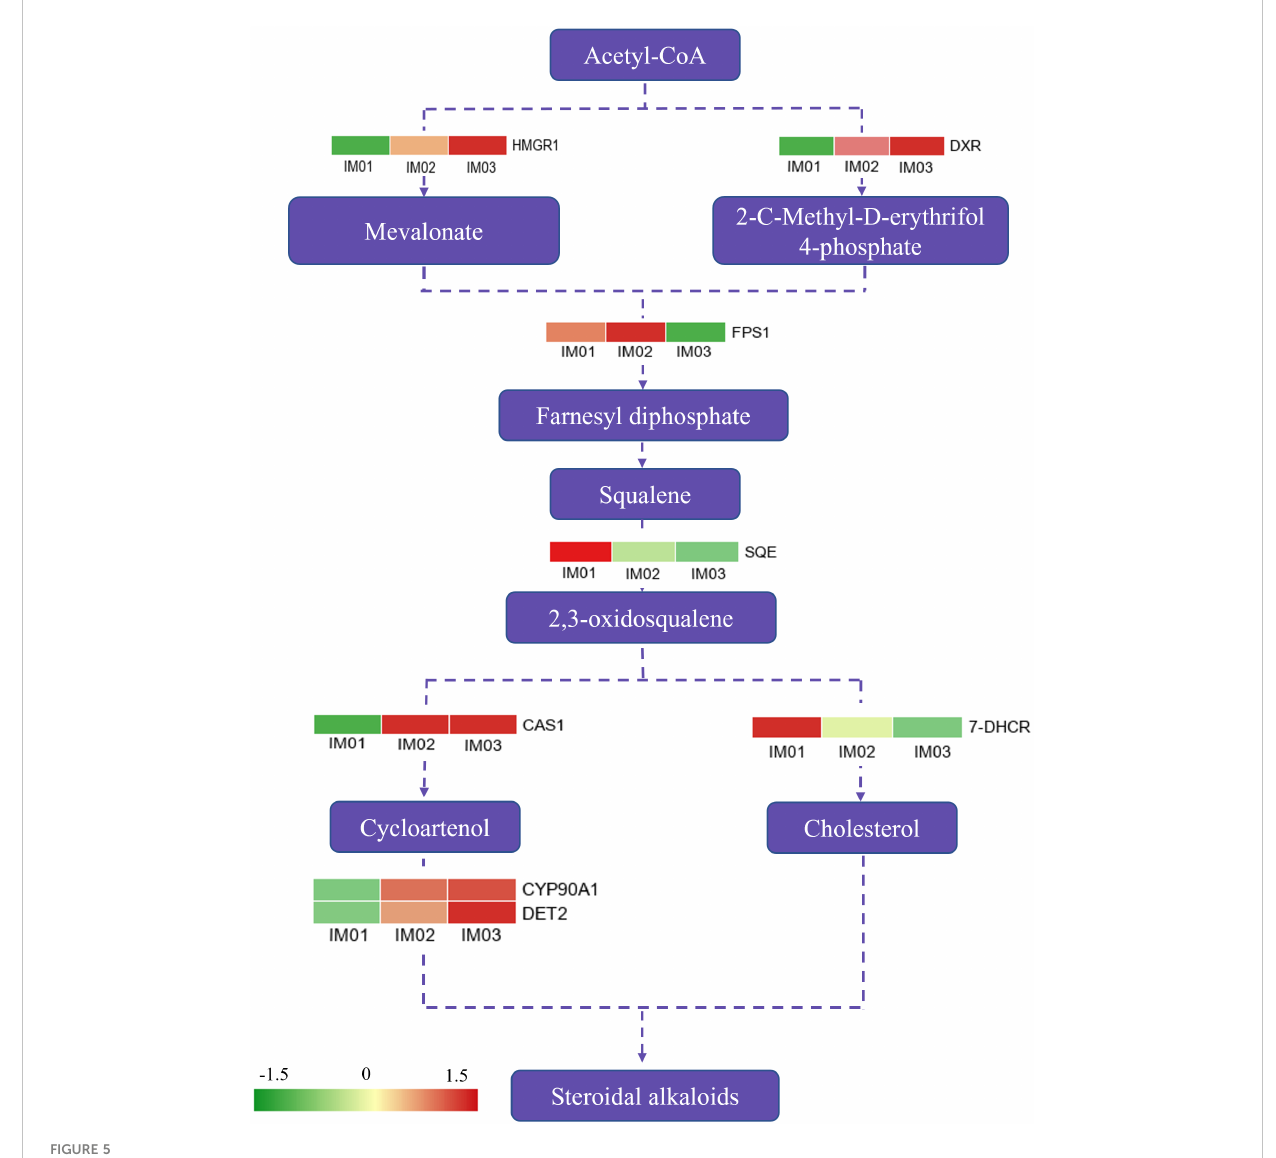
FIGURE 5 DEGs in proposed steroidal alkaloid